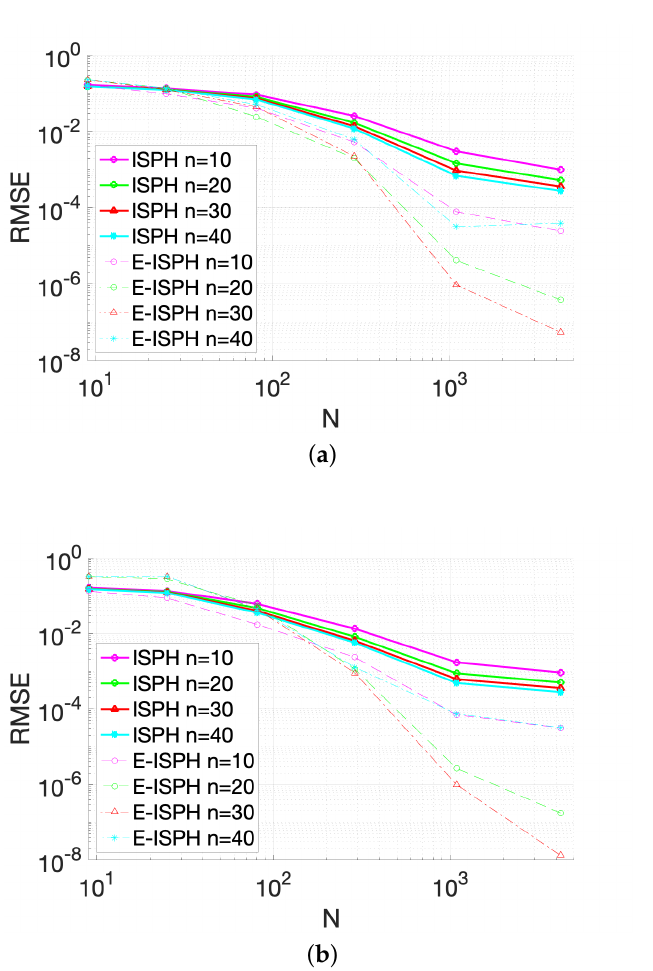
Figure 4. RMSEs versus number of data sites. Comparison between ISPH and E-ISPH. ( a ) Ξ G ; ( b ) Ξ H . Full line is for ISPH and dashed line is for E-ISPH. All the computations are with starting normalized values and 10 ≤ n ≤ 40.